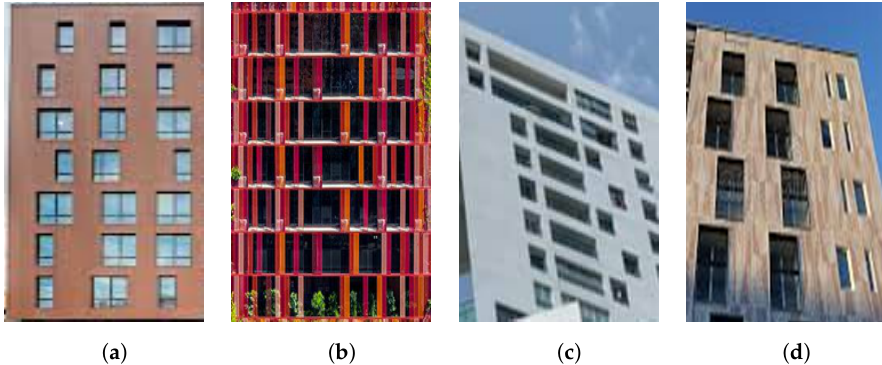
Figure 6. Reference images of distinctive facade layouts for the synthetic data ( a – d ). Refer to Table 1 for more detail information about the synthetic facade point clouds.